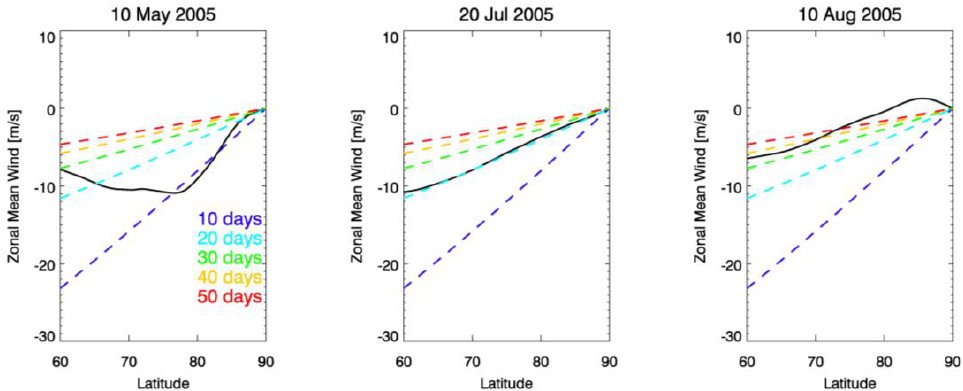
Fig. 12. Zonal mean zonal wind (black line) as a function of latitude at 850K for 10 May, 20 July, and 10 August 2005. Color curves indicate the winds necessary for solid-body rotation with periods of 10 (blue), 20 (cyan), 30 (green), 40 (yellow), and 50 (red) days.